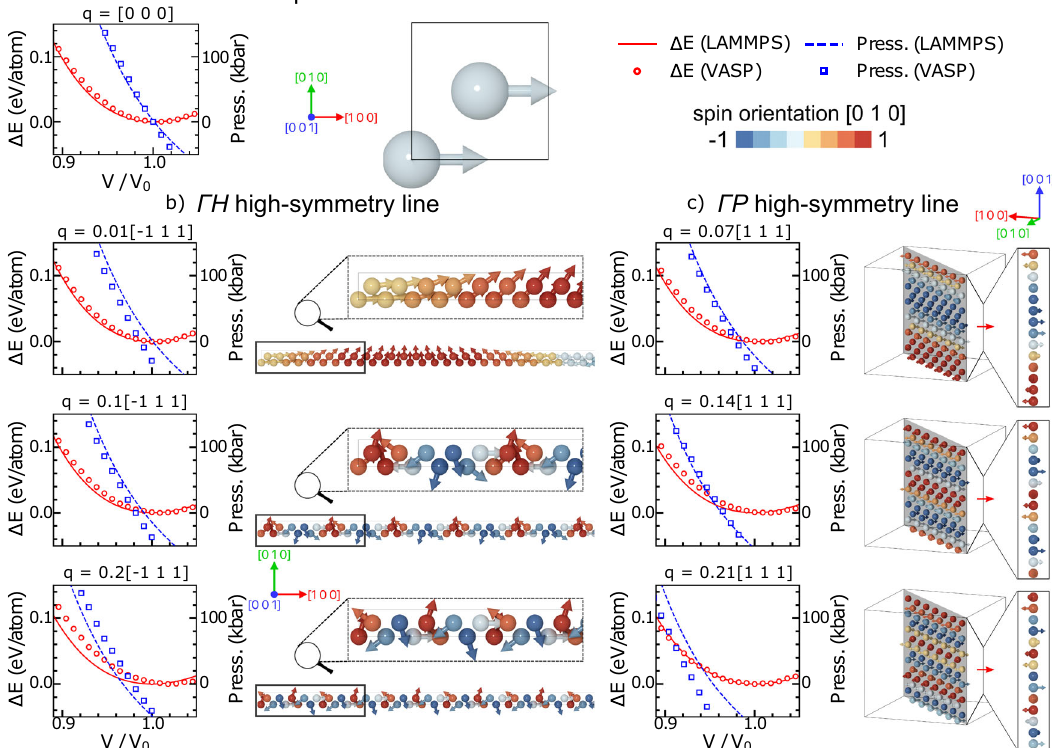
Fig. 3 Magneto-static accuracy results. Plots of the equation of state data from fi rst-principles calculations (VASP computations) and our magneto-elastic ML-IAP (LAMMPS computations) for seven different spin-spirals: a Γ point ( b ) vectors along the Γ H high-symmetry line, and c vectors along the Γ P high-symmetry line. Visualizations of the corresponding spin-spiral supercells and associated q-vectors are shown to the right of and above each plot,